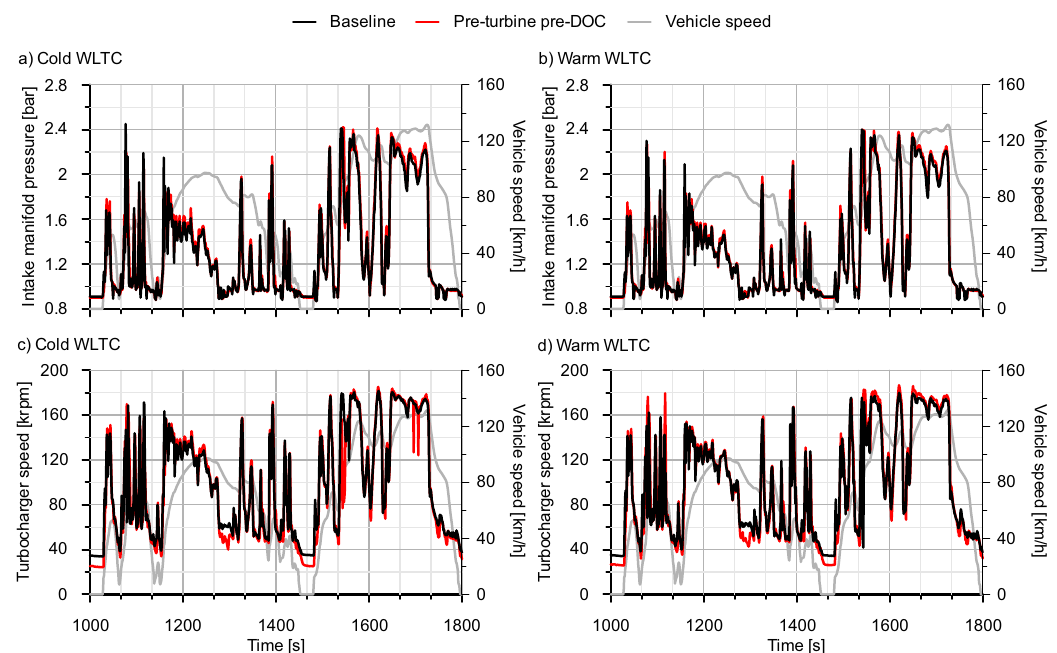
Figure 6. Intake manifold pressure and turbocharger speed in cold and warm WLTCs with baseline ATS and pre-turbine pre-DOC configurations during the high- and extra-high-speed phases. ( a ) Intake manifold pressure in cold WLTC, ( b ) intake manifold pressure in warm WLTC, ( c ) turbocharger speed in cold WLTC, ( d ) turbocharger speed in warm WLTC.